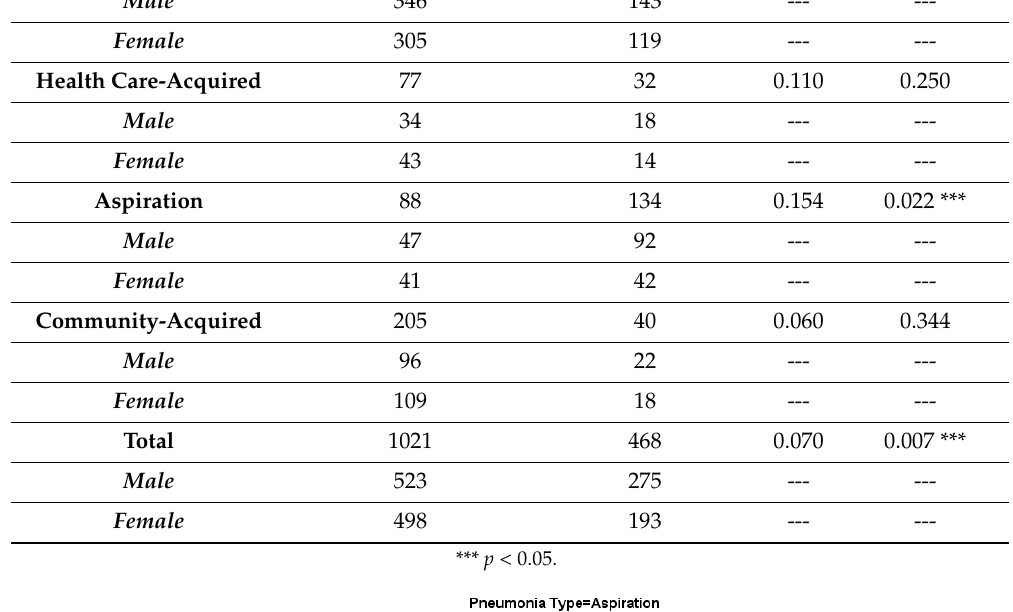
Table 4. Categories and gender.